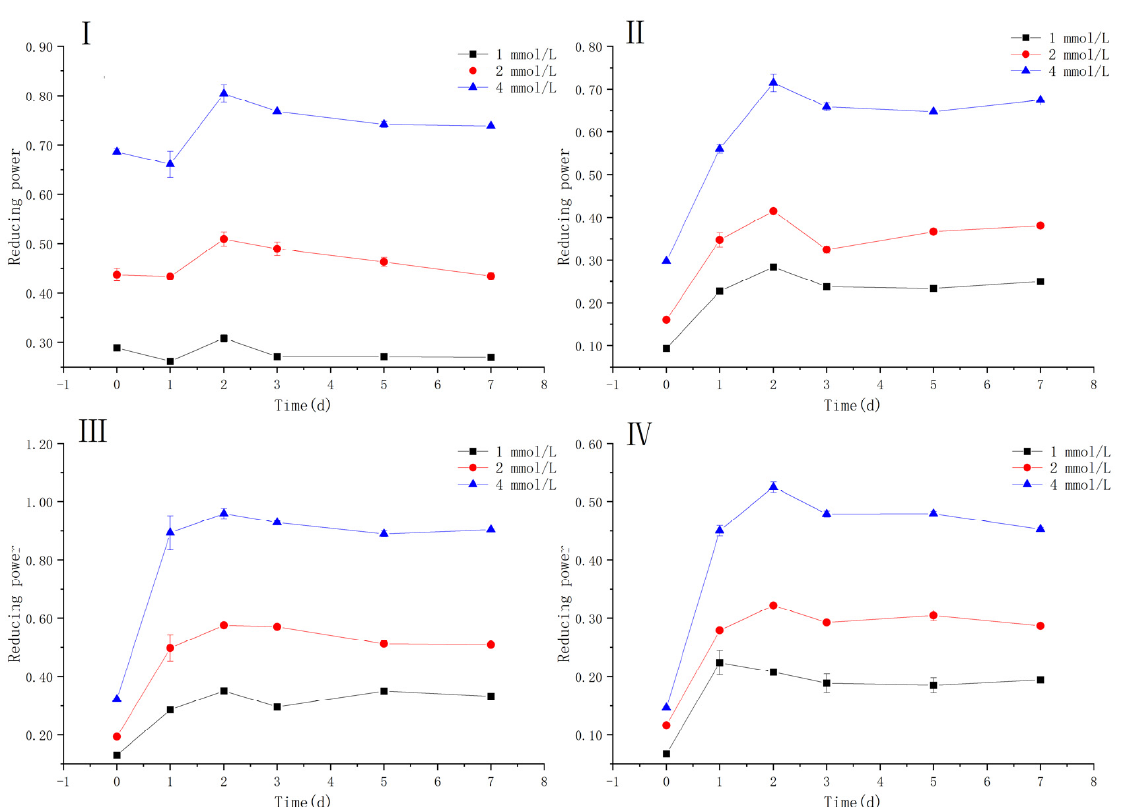
Figure 5. The reducing power of autoxidation products of ( I ) Catechin ( II ) Epicatechin ( III ) Caffeic acid ( IV ) Chlorogenic acid in various concentrations at pH 3.5.